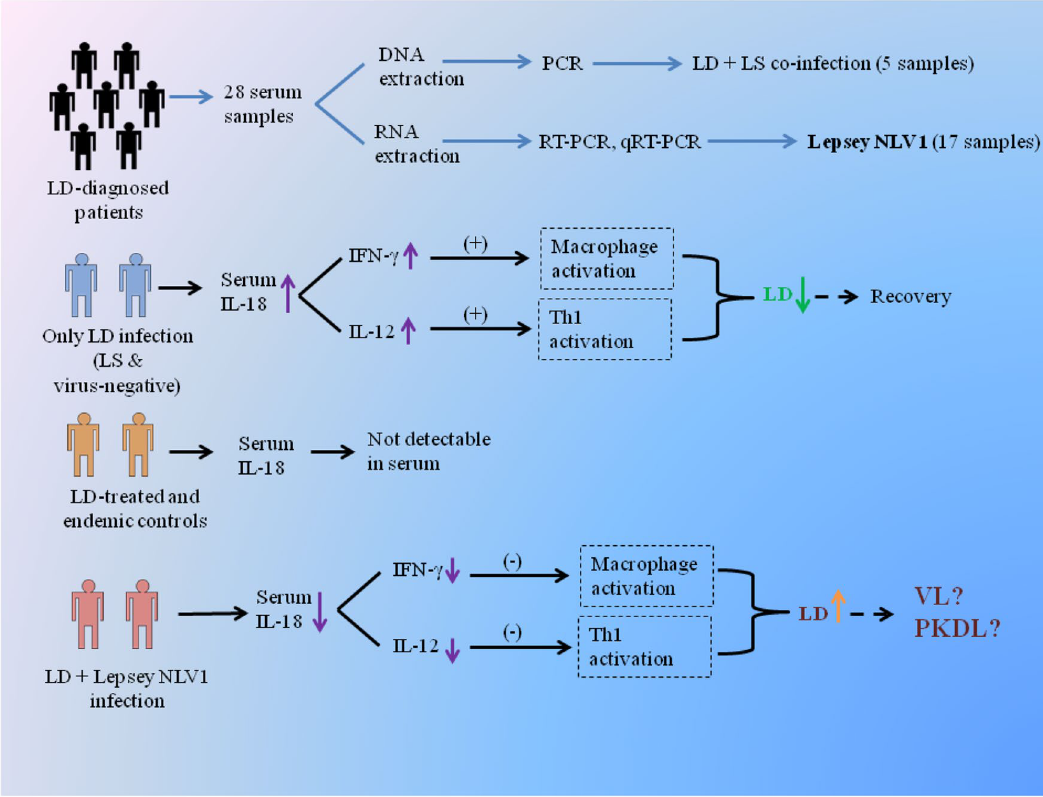
Figure 4. Schematic representation of putative role of Lepsey NLV1 in promoting persistence of LD. LD: Leishmaina donovani ; LS: Leptomonas seymouri ; Lepsey NLV1: Leptomonas seymouri narna like virus 1; Vertical up-arrow: up-regulated; Vertical down-arrow: down-regulated; (+): activation; (−): no